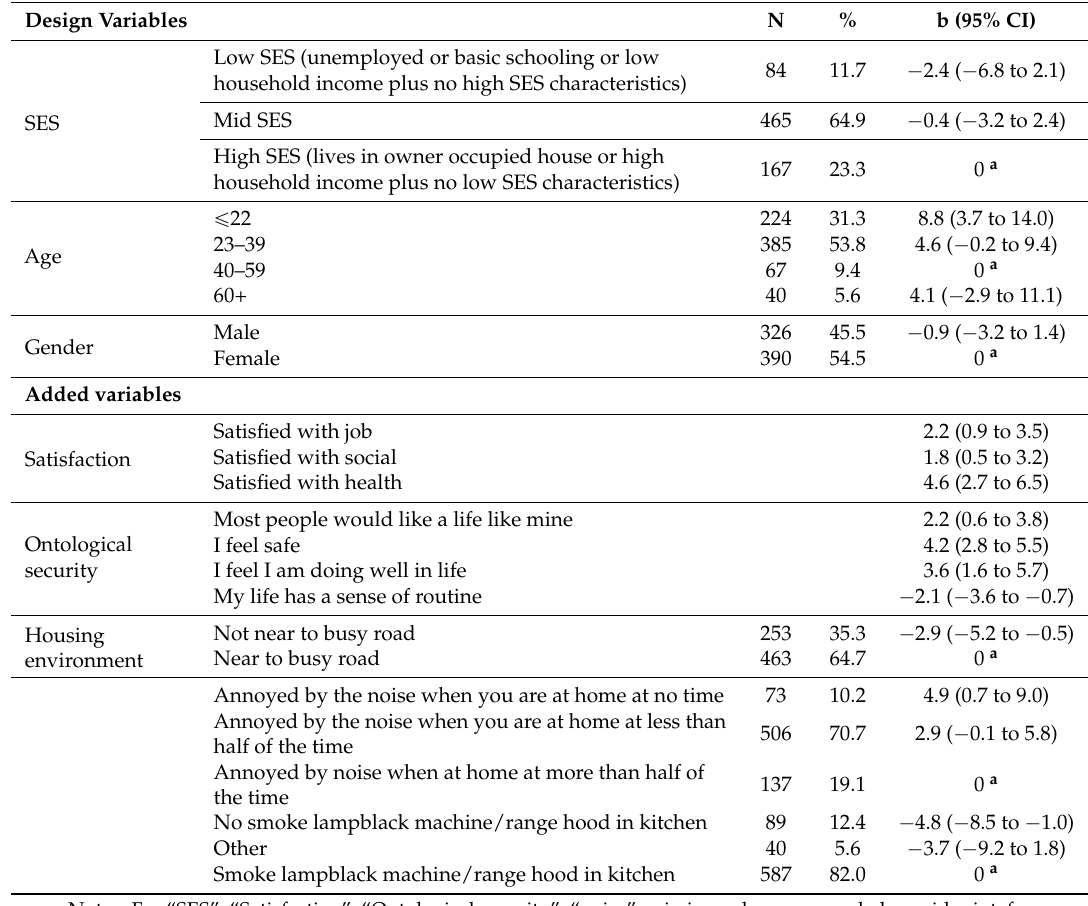
Table 5. The results of generalized estimation equation